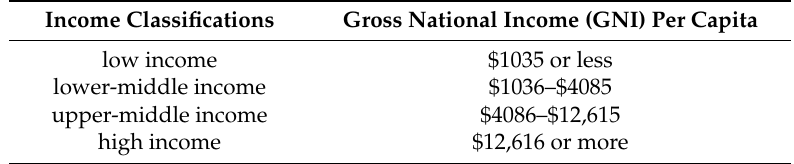
Table 2. Income classifications by gross national income (GNI) per capita according to the World Bank.